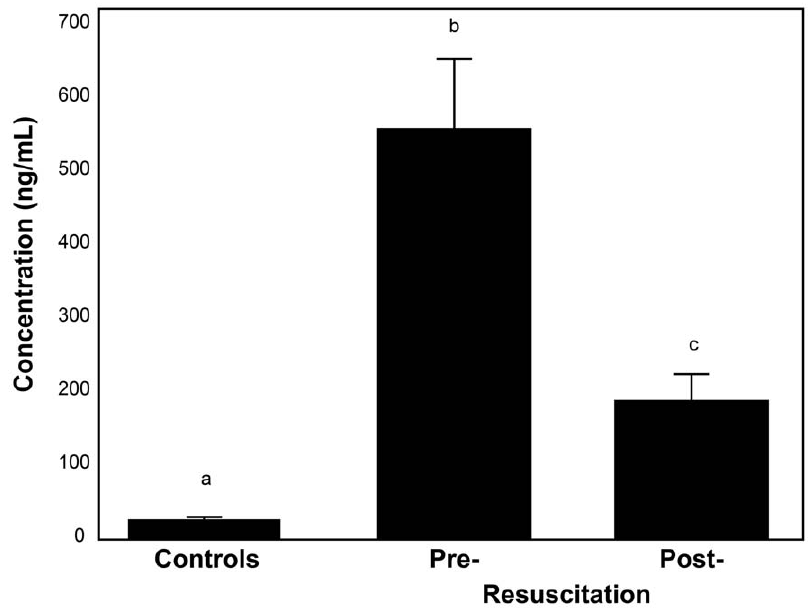
Figure 1. Syndecan-1 is shed following hemorrhagic shock. Plasma syndecan-1 was measured in patients presenting in hemorrhagic shock. The mean plasma concentration is shown for controls, pre-resuscitation, and post-resuscitation time points. Syndecan-1 concentrations were markedly elevated pre-resuscitation and remained significantly elevated post-resuscitation compared to controls. Resuscitated patients reached the ICU an average of 7 6 0.75 hours after arrival in the emergency room. Results are presented as mean 6 SEM, means notated with letters indicate statistical differences between groups.